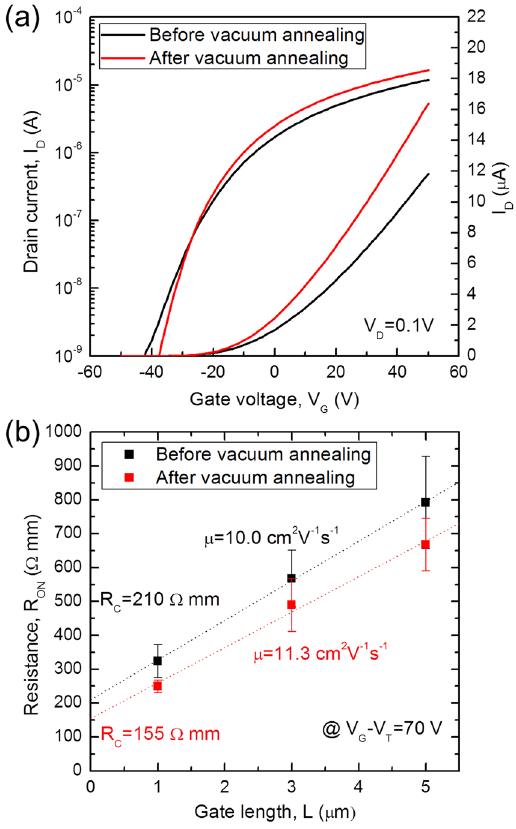
Figure 4. Effects of vacuum annealing on the electrical characteristics of the monolayer MoS 2 FETs. ( a ) Drain current ( I D ) of the monolayer MoS 2 FET as a function of gate voltage ( V G ) before and after vacuum annealing (400 K for ~14 hr), measured under vacuum (~6.0 × 10 − 8 Torr). ( b ) Contact resistance ( R C ) and mobility ( μ